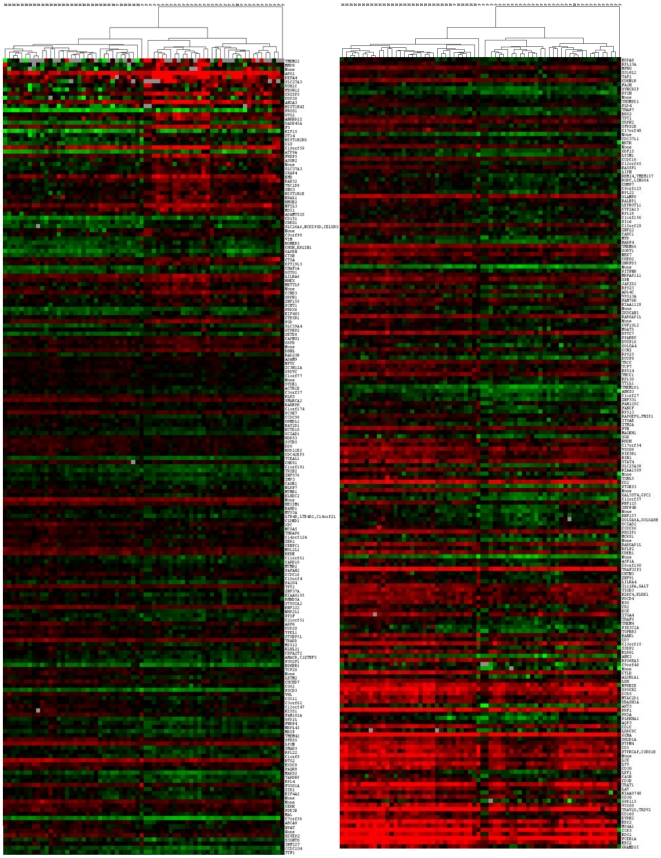
Global gene expression analysis in PBMCs from PC patients and healthy controls.Hierarchical cluster analysis of global gene expression profile by cDNA whole genome microarray comparing healthy control and PC samples using all genes found to be statistically differentially expressed between the two groups (FDR<0.10, n = 383 genes). In no instance were samples pooled. Red indicates genes whose expression is elevated relative to the universal human reference (used to normalize all arrays) and green indicates genes whose expression is decreased relative to the universal human reference.